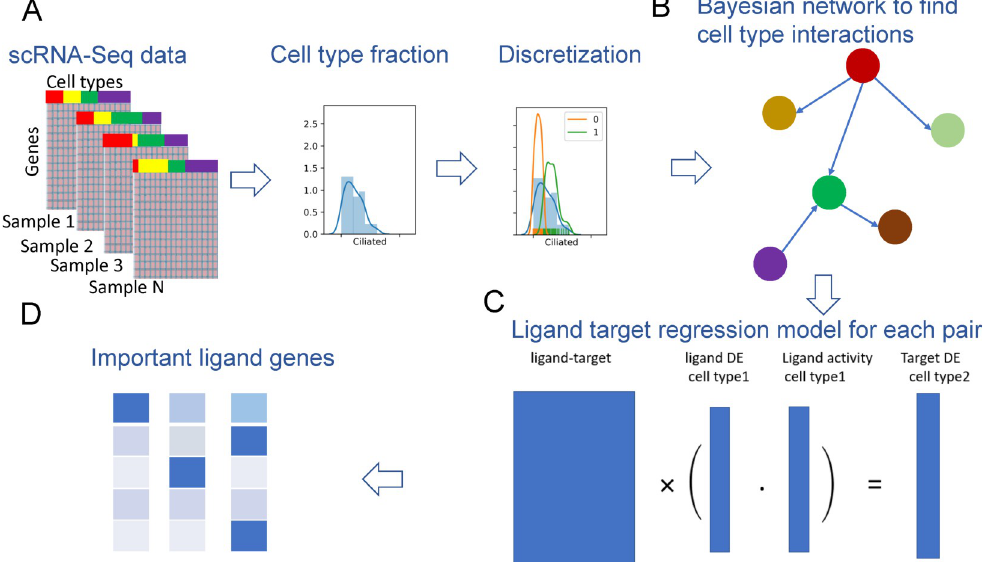
Fig 1. Overview of CINS. (A) Cell type annotation is used to extract cell type fractions in each sample. Next cell type fraction is discretized by learning Gaussian Mixture Model (GMM) for this type, respectively. (B) A Bayesian network (BN) is learned using the discretized cell abundance information. Bootstrapping is performed to identify high scoring differential interactions between cell types. (C) For pairs identified in the directed bootstrap BN analysis, a ligand-target regression (LTR) model is learned. In this model we use the expression change of ligands in the cell type with the outgoing edge to predict the expression of targets genes in the cell type with incoming edge. (D) Finally, LTR is used to select key ligands that underlie the cell-cell interactions identified in the BN. cell